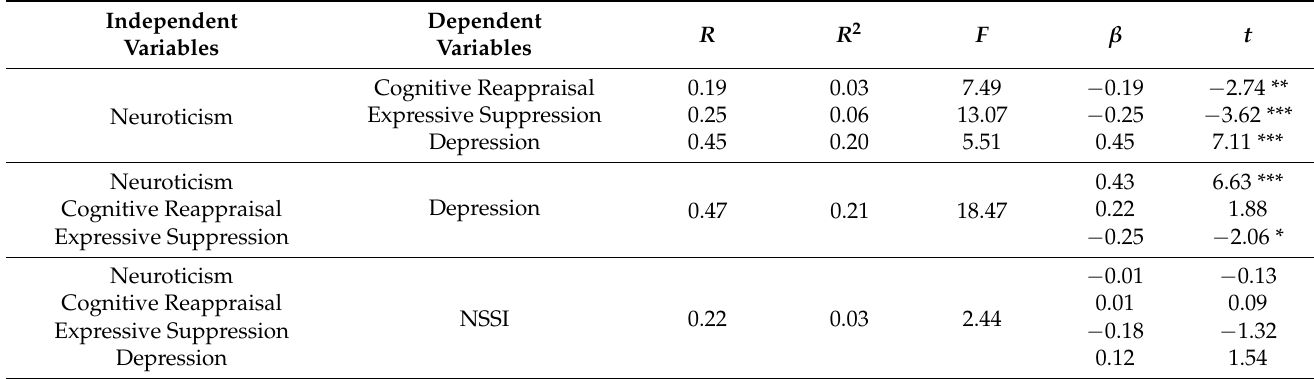
Table 4. Multivariate regression analysis of neuroticism, emotion regulation (ER), depression, and NSSI among male college students.